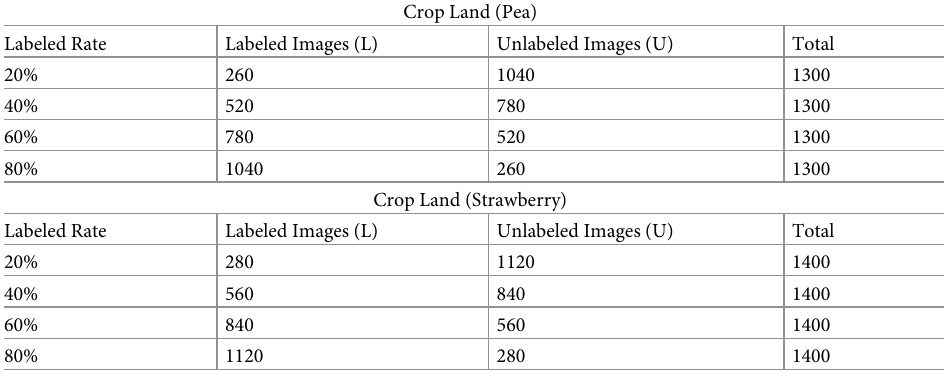
Table 1. Number of the labeled and unlabeled Images under different labeled rates for two different croplands. Crop Land